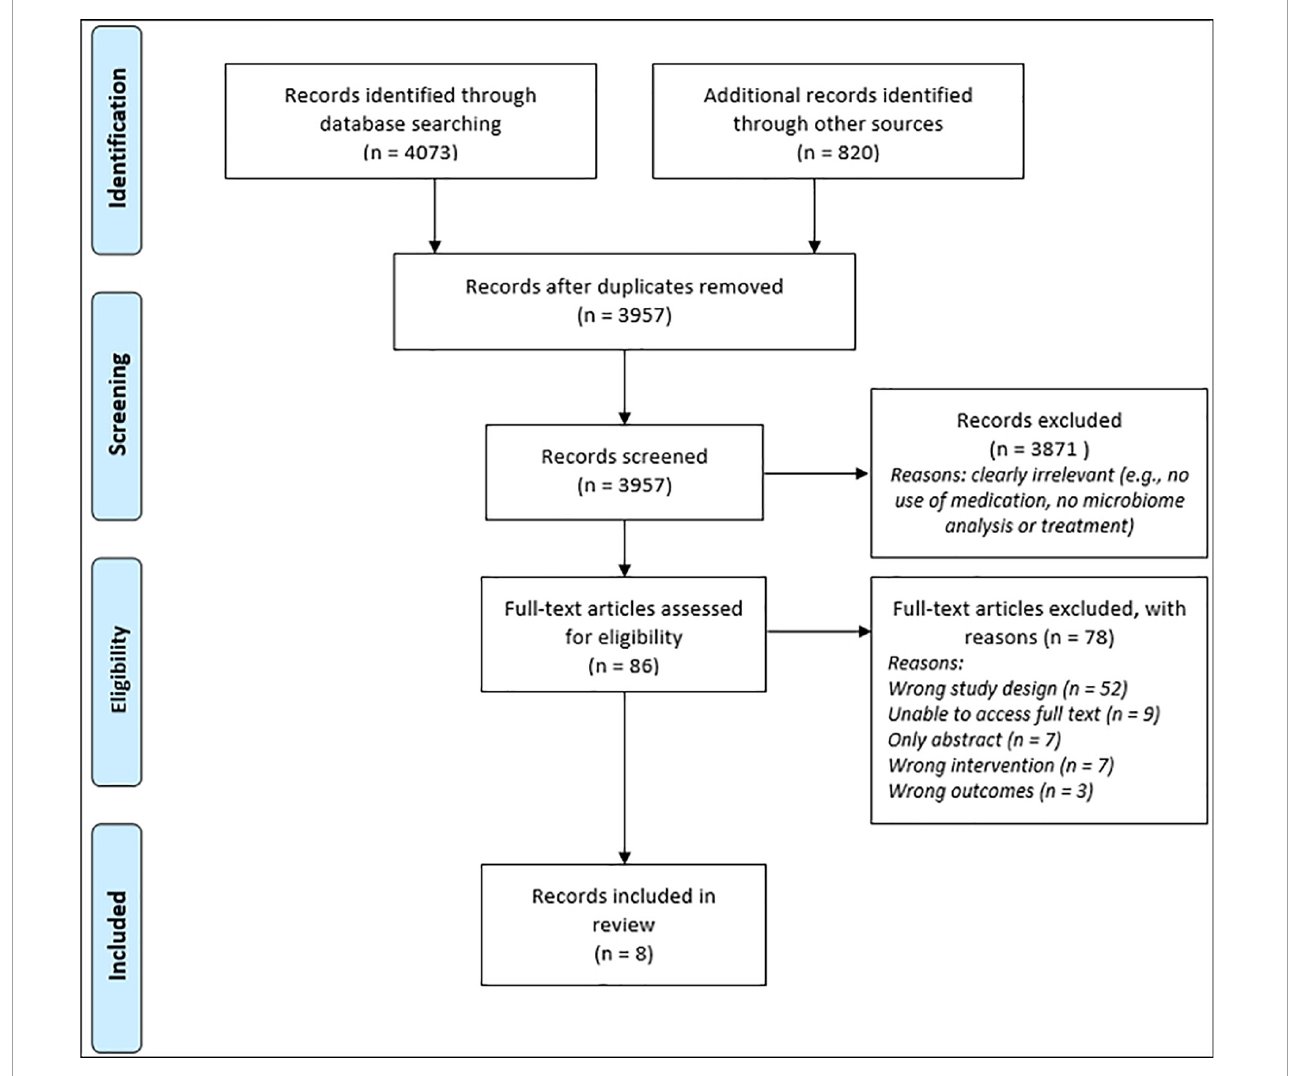
FIGURE1 Flow chart showing literature search and screening process using PRISMA